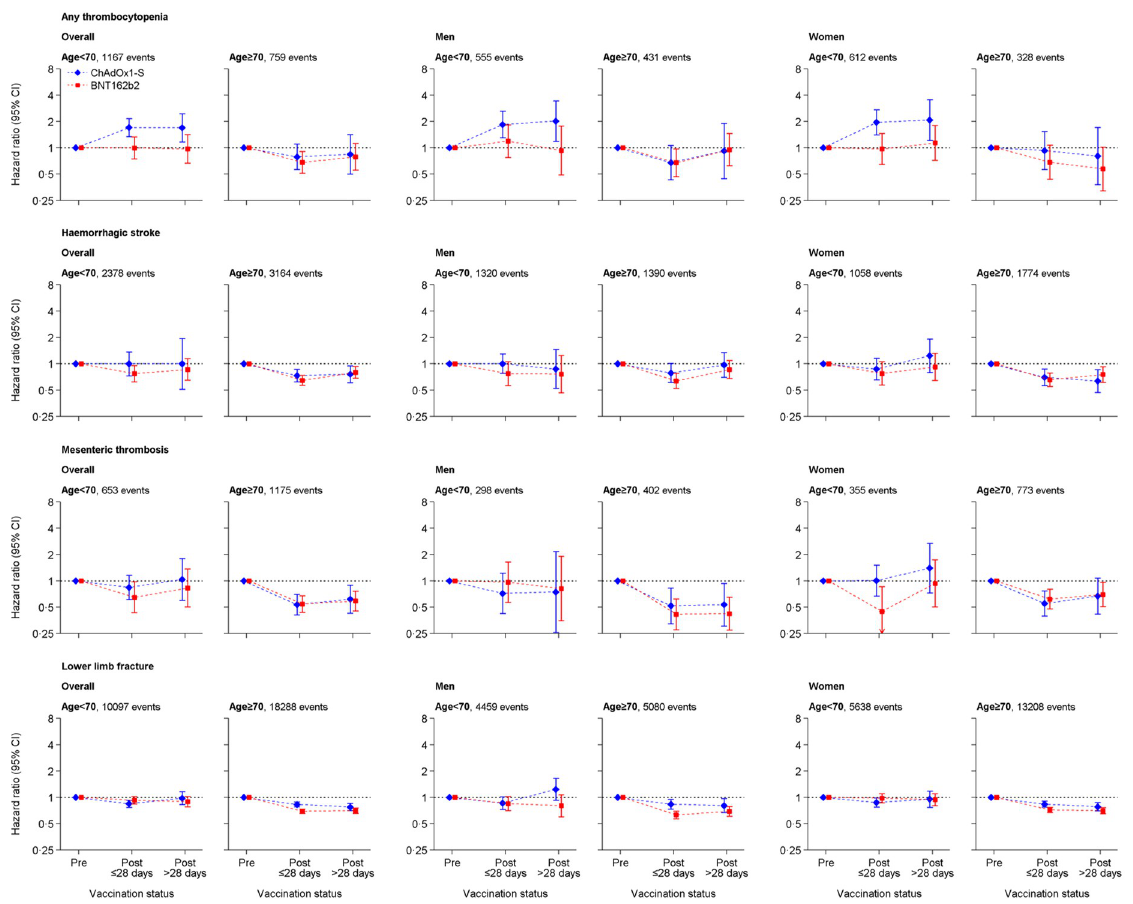
Fig 3. aHRs for thrombocytopenia, haemorrhagic stroke, mesenteric thrombosis, and lower limb fracture after ChAdOx1-S or BNT162b2 vaccine. CI, confidence